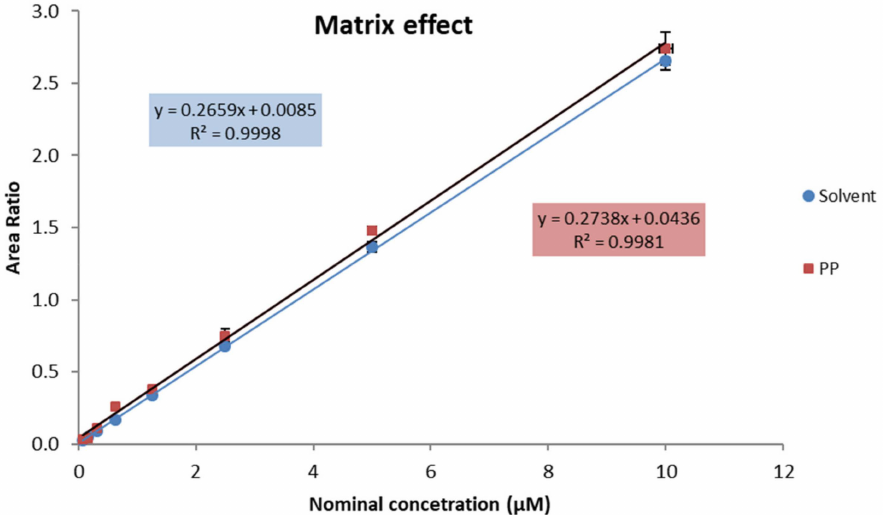
Figure 3. Representative curves of HArg standard dissolved in solvent (in blue) or in plasma pool sample (PP, in